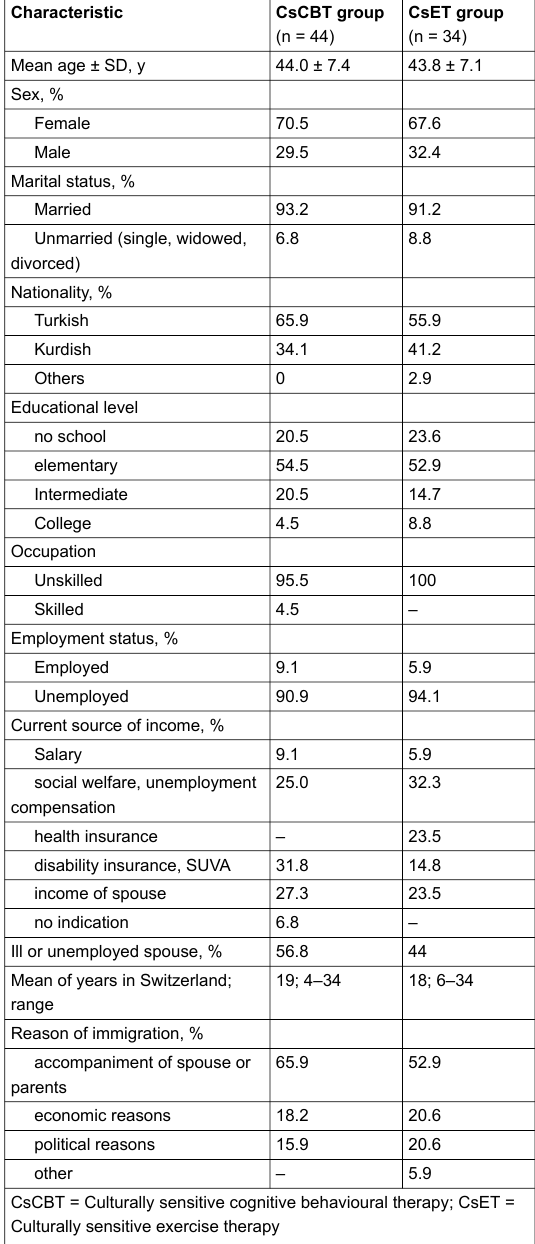
Table 1: Demographic characteristics of group